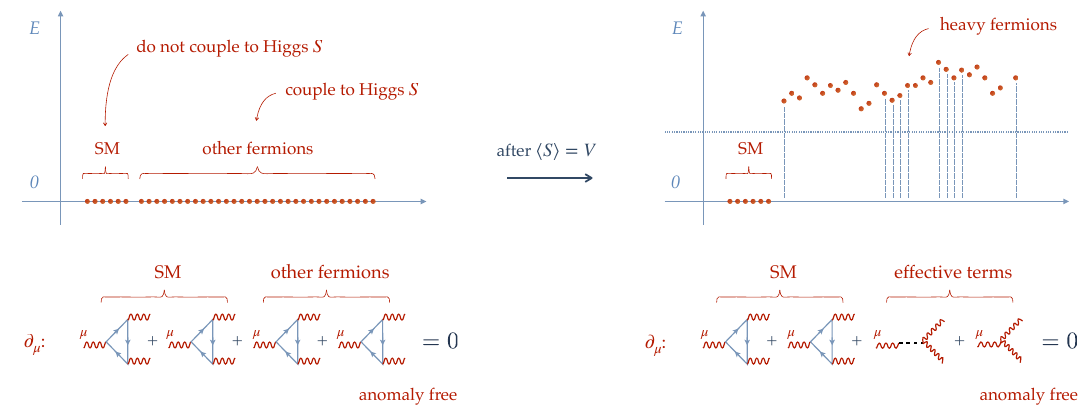
Figure 5 . A schematic representation of the